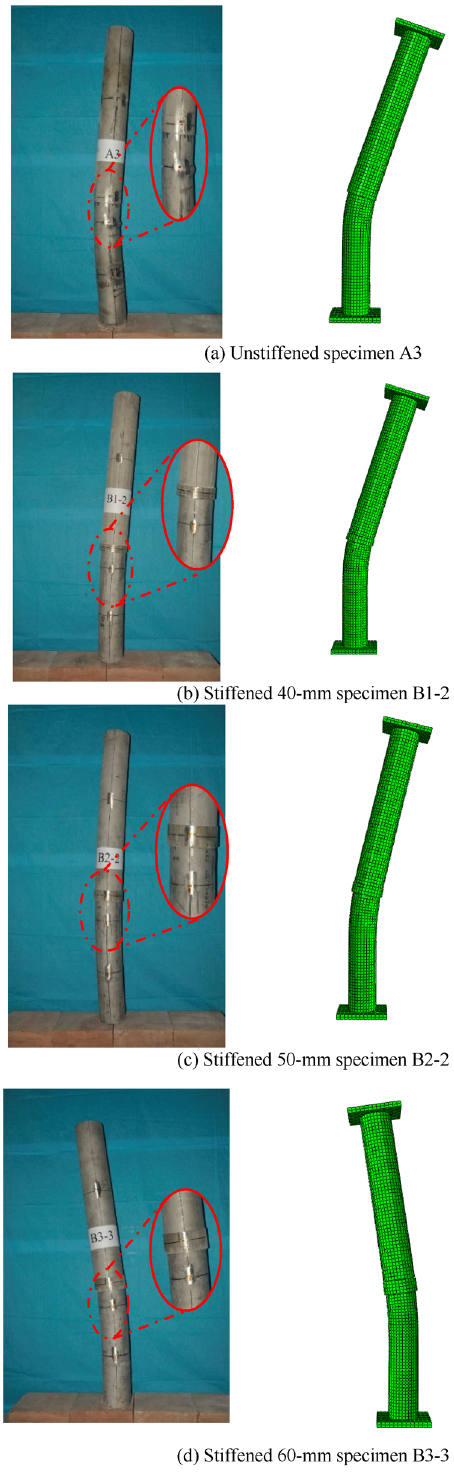
Fig. 15 Comparison of failure modes under axial